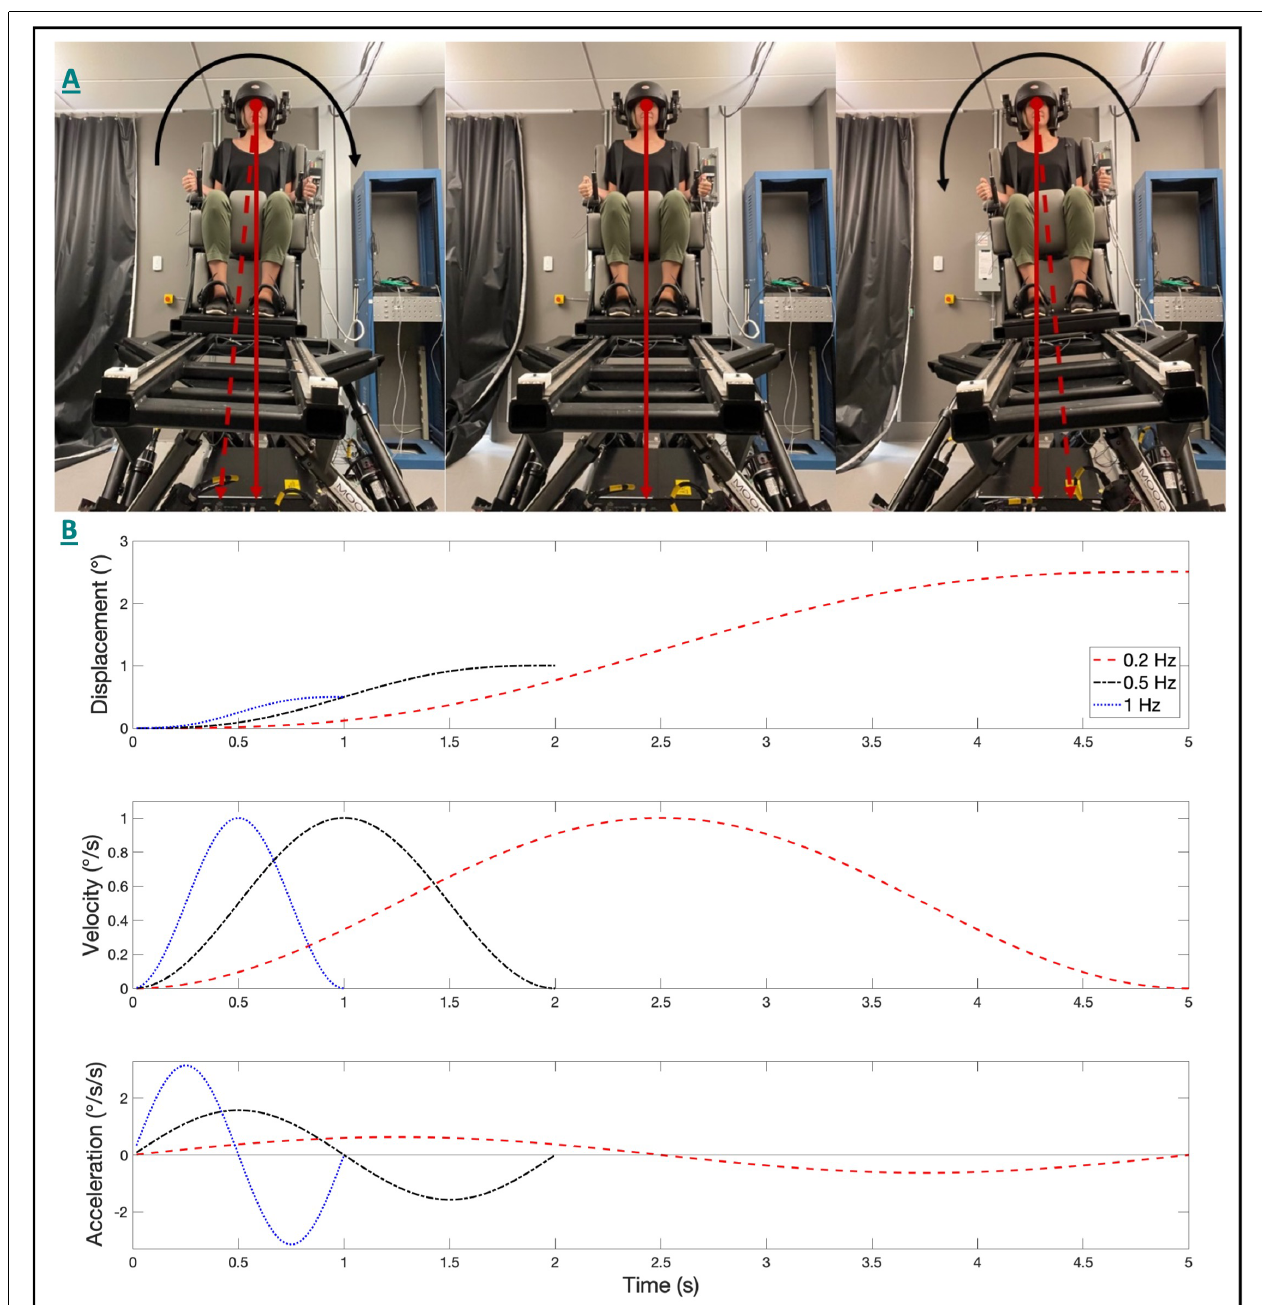
FIGURE 1 | The 6DOF motion platform set up and the head-centered roll tilt motion is shown (A) . The angular displacement (top), velocity (middle), and acceleration (bottom) trajectories for single cycle acceleration stimuli are shown (B) for each of the three frequencies of roll tilt. The peak angular velocity was held constant at 1 ◦ /s for each condition. Note that for identical peak velocities, that displacements decreased, and peak accelerations increased as the frequency increased.